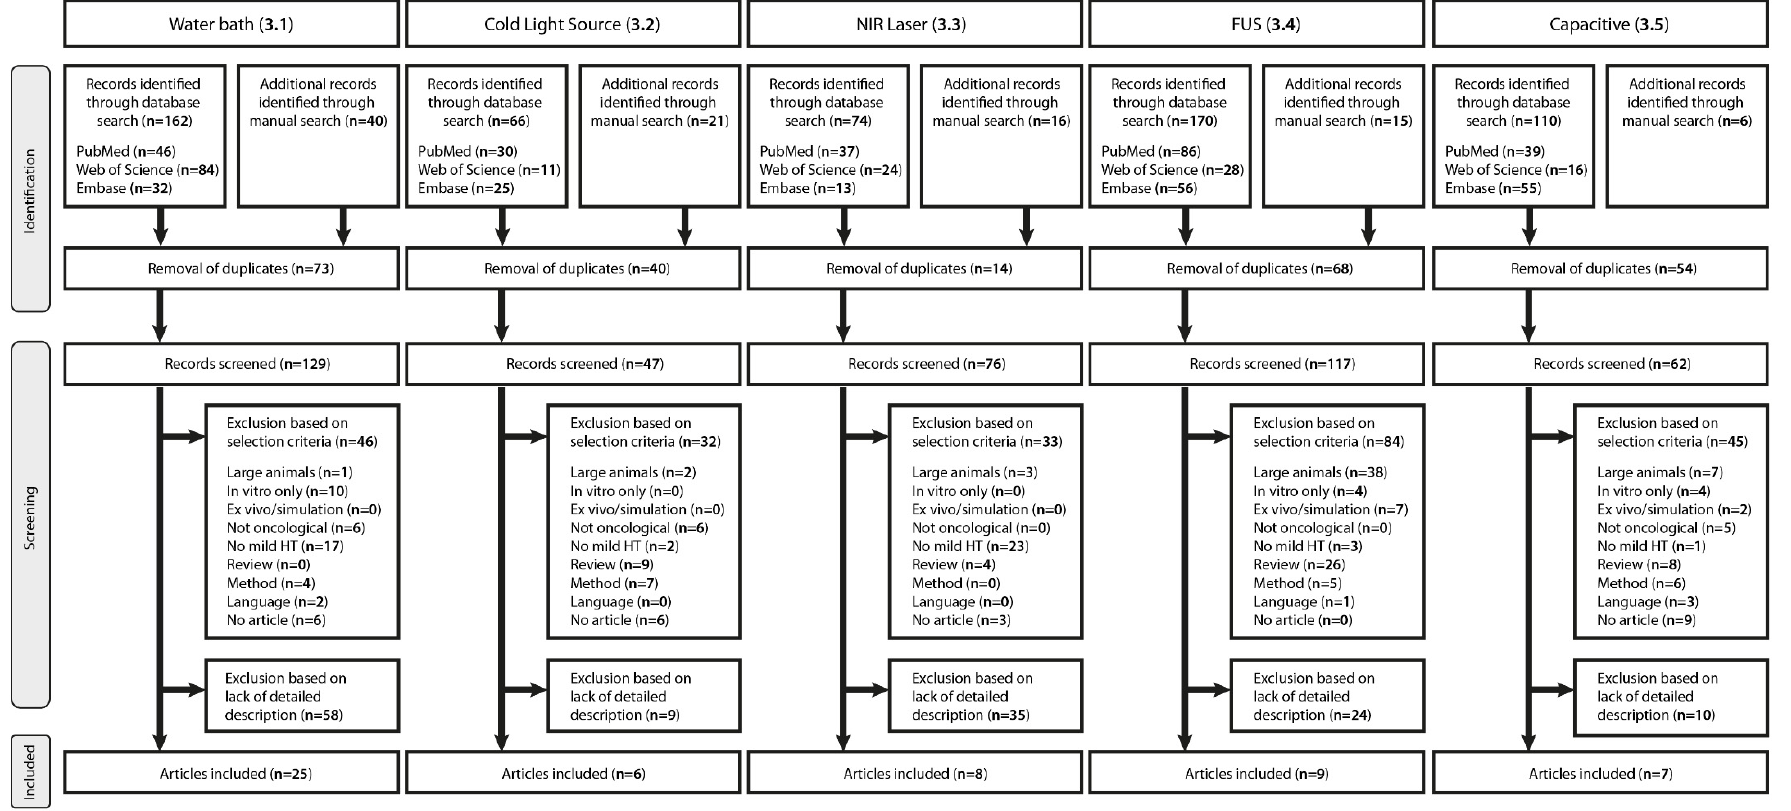
Figure 1. PRISMA flow diagram illustrating selection of the articles for each hyperthermia technique. This review presents a detailed description of the water bath (Section 3.1), cold light source (Section 3.2), NIR laser (Section 3.3), FUS (Section 3.4), and capacitive hyperthermia (Section 3.5) methods.